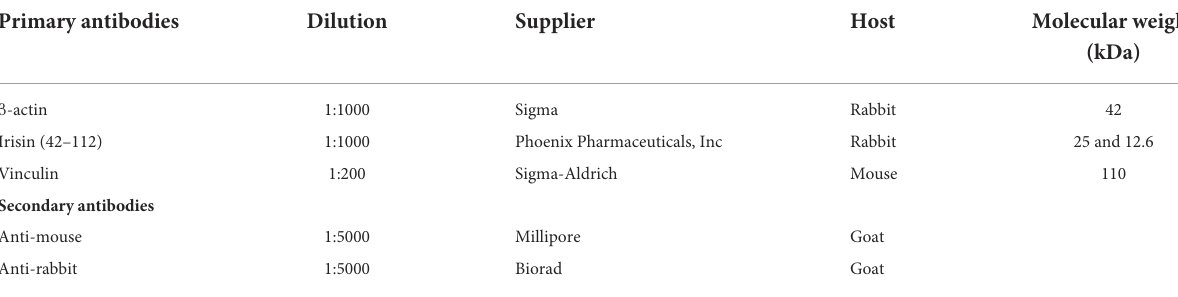
TABLE 4 List of antibodies used for the detection of proteins by Western blot. Primary